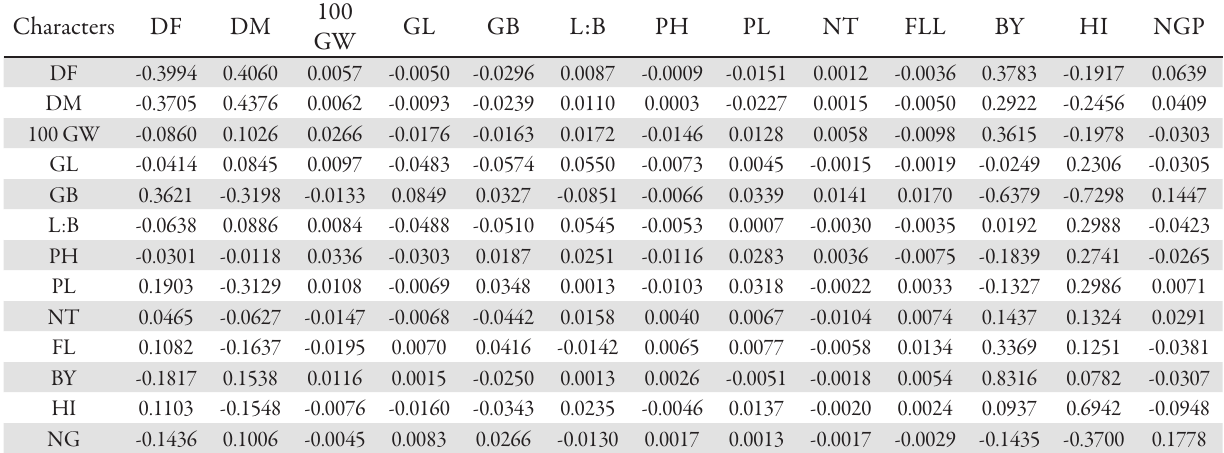
Tab. 4. Path coefficient analysis for fourteen agro-morphological characters in F